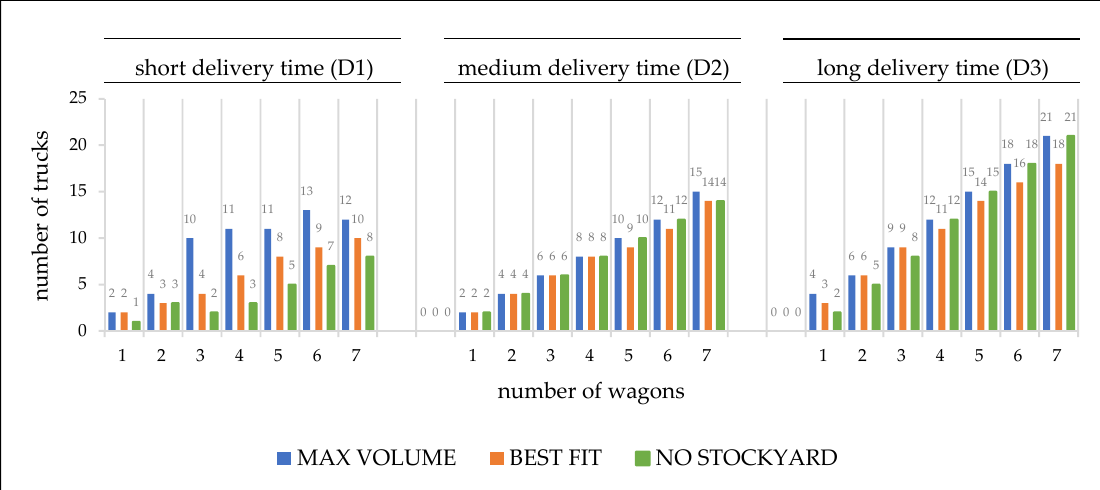
Figure 3. Best performing truck to wagon ratios for one train pick ‐ up and low tonnages regarding three strategies.